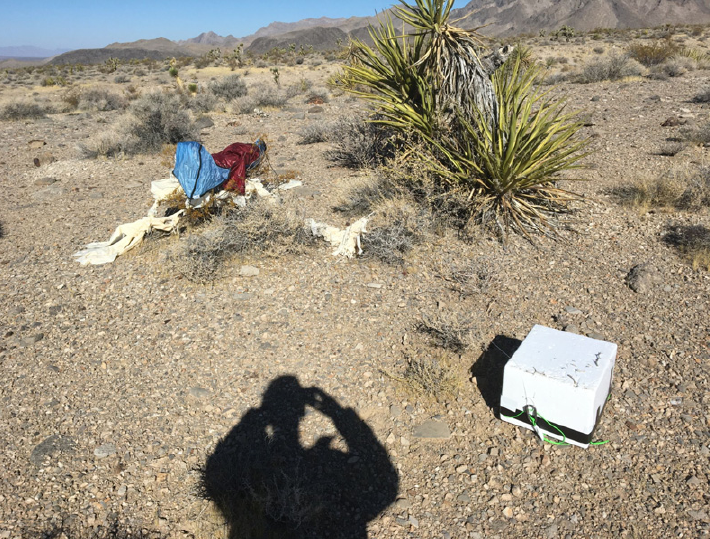
Figure 2. Landing site, with payload box flipped upside down on the lower right and the parachute (blue and red) tangled with balloon shreds in the upper left.